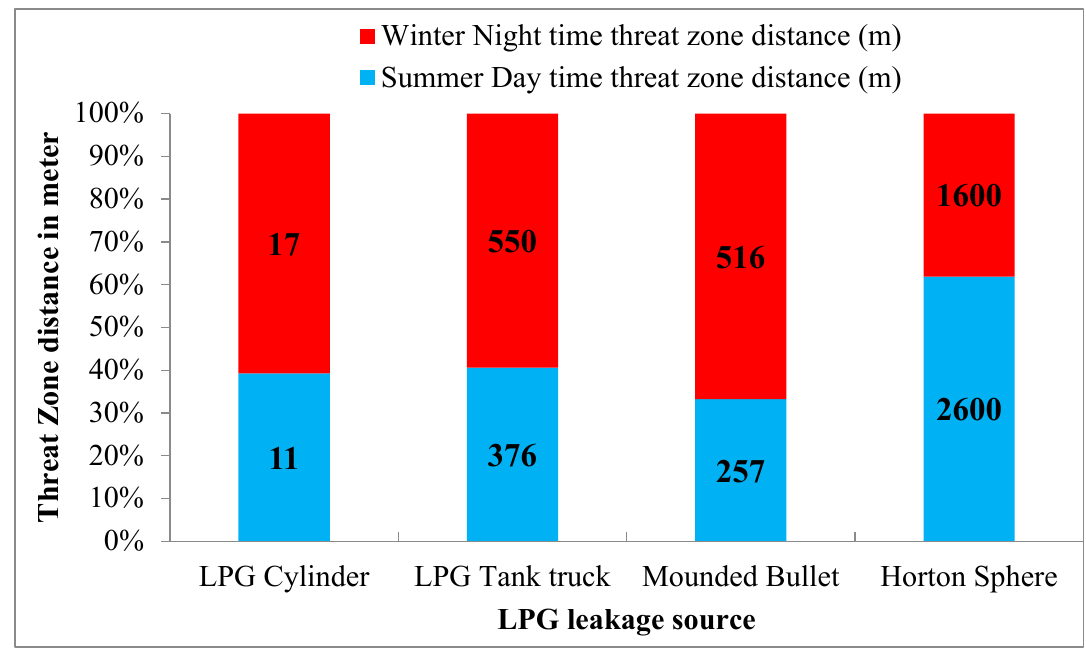
Figure 5. Flammable area of vapour cloud for lower explosive limit (LEL).